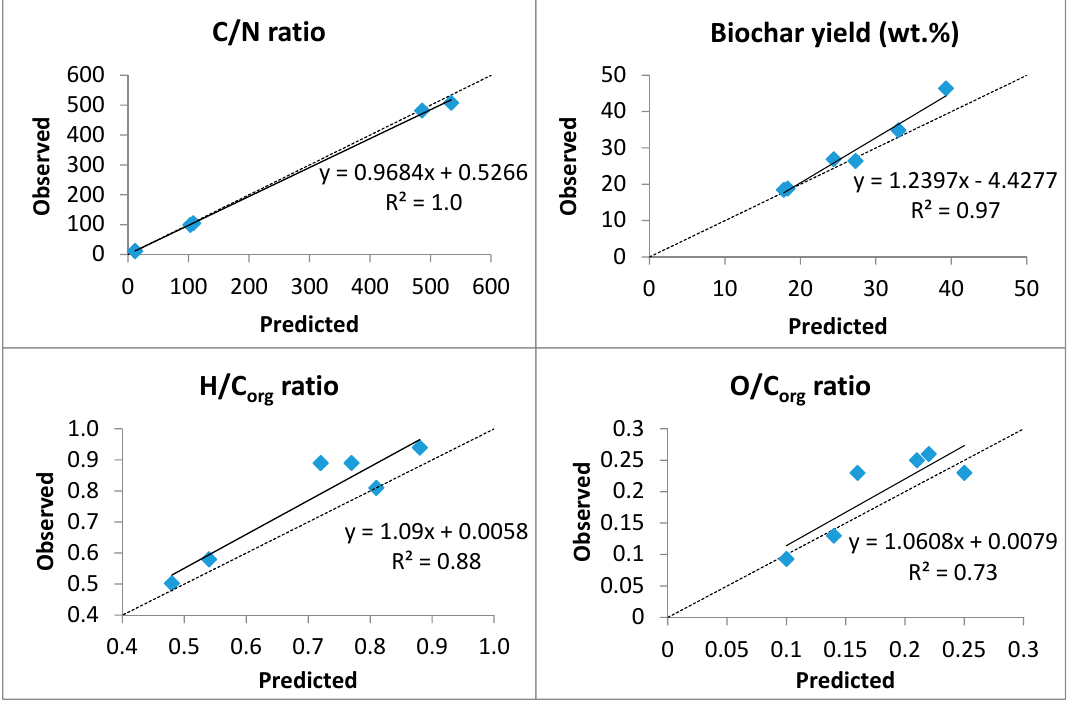
Figure 2. Biochar yield, C/N, H/C org , and O/C org ratios: observed vs. predicted values.